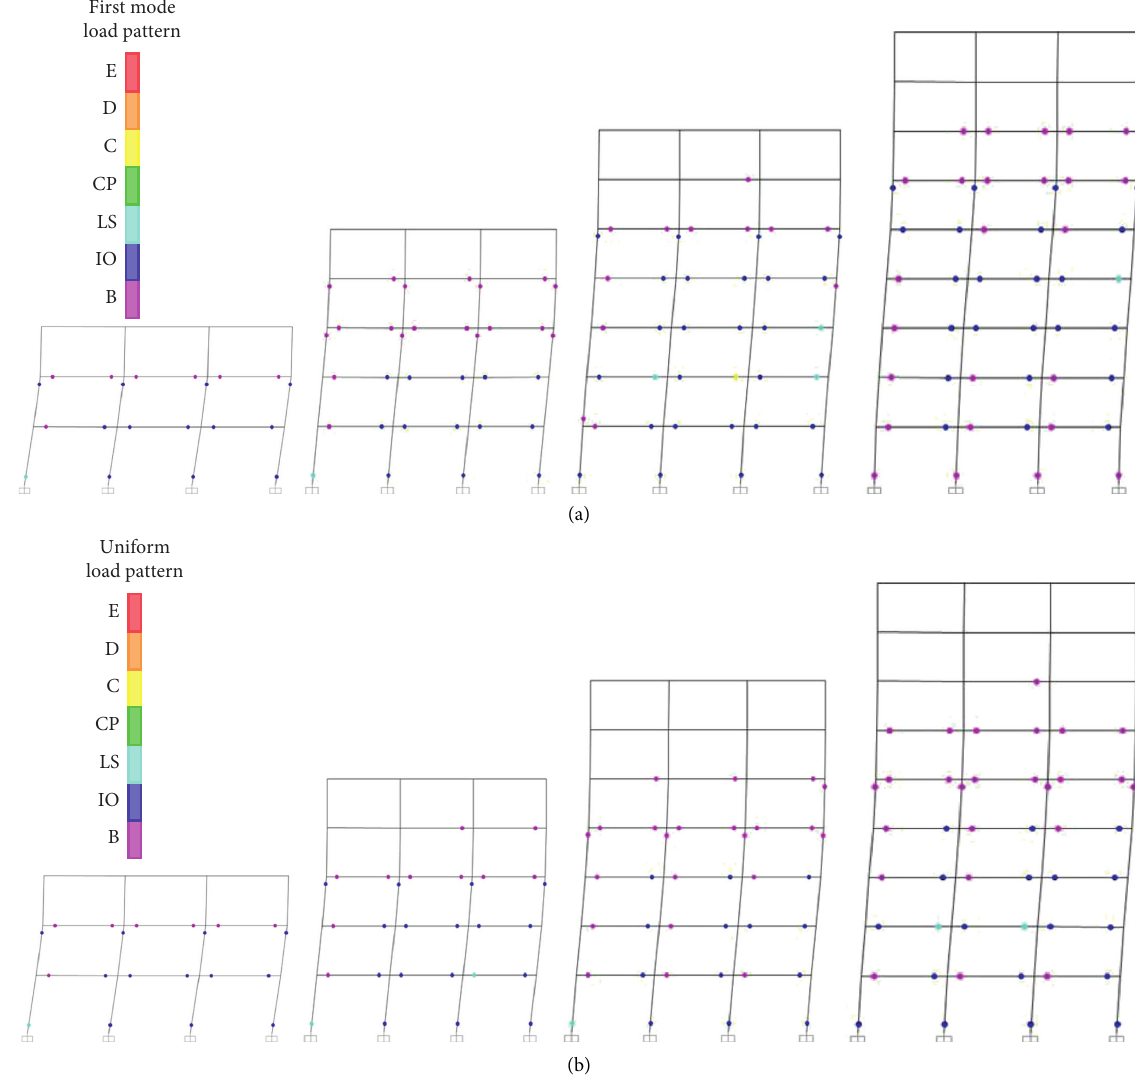
Figure 7: Collapse mechanism and distribution of plastic hinges at Life Safety Limit State. Pushover analysis of 3-bay RC